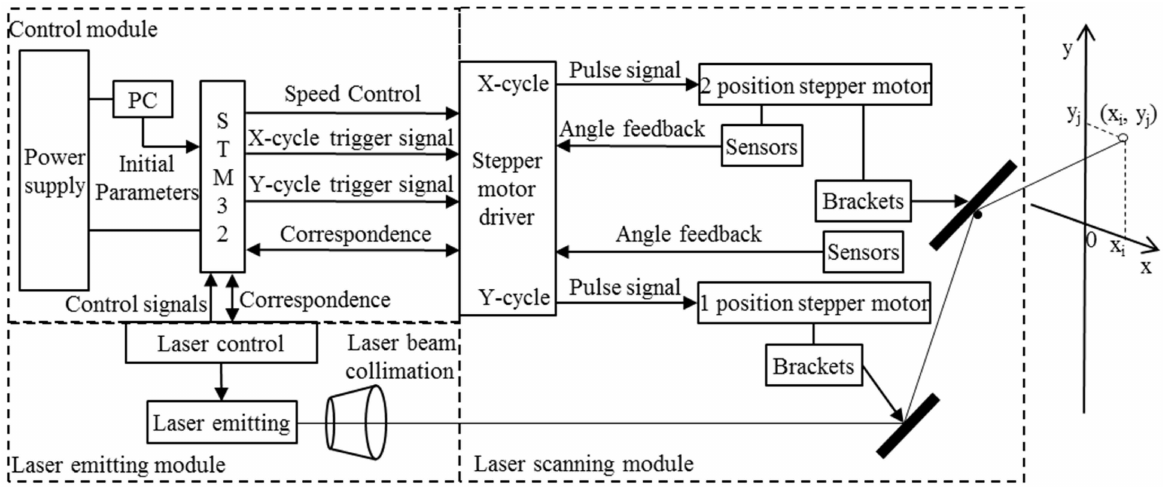
Figure 4. Architecture of the scanning optical system.